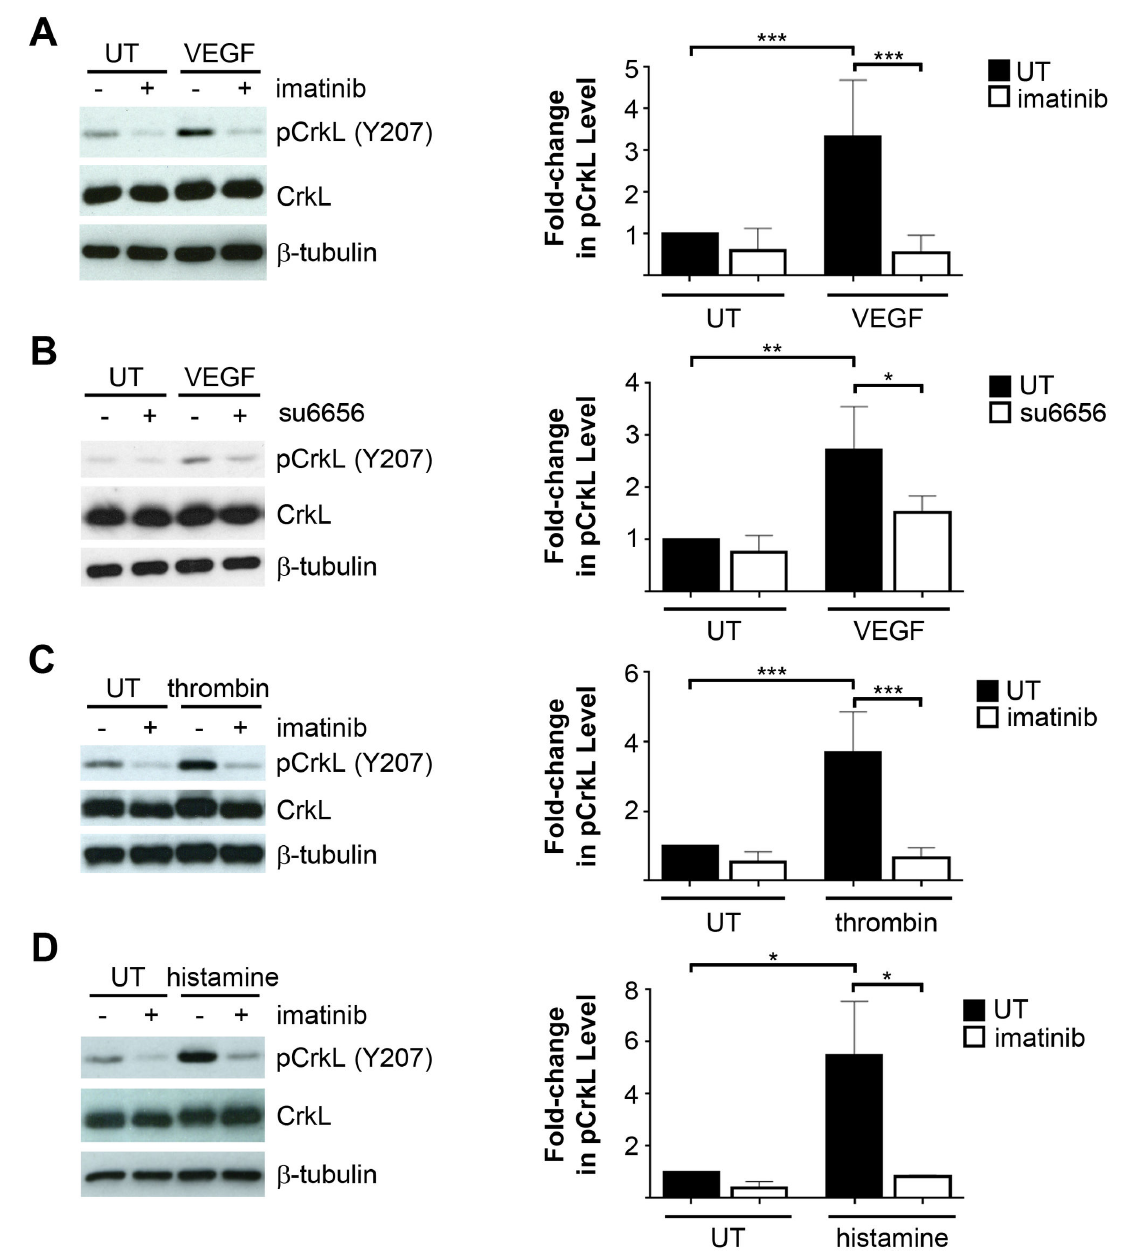
Figure 1. Abl kinases are activated following treatment with endothelial permeability-inducing factors. ( A ) Assessment of Abl kinase activation, as determined by phospho-CrkL tyrosine (Y) 207 levels, following stimulation of serum-starved HMVECs with 100ng/mL VEGF for 5 minutes, with or without imatinib pre-treatment (10μM). pCrkL (Y207) levels (normalized to total CrkL) are quantified in the right panel, relative to levels in untreated (UT) cells. Data are presented as means +/- SD (n=7). ( B ) Evaluation of pCrkL (Y207) levels in HMVECs treated with VEGF, with or without su6656 pre-treatment (1μM). pCrkL levels (normalized to total CrkL) are quantified in the right panel, relative to levels in untreated (UT) cells. Data are presented as means +/- SD (n=2). ( C ) Evaluation of Abl kinase activation (pCrkL Y207) following treatment of HMVECs with thrombin (1U/mL, 5 minutes), with or without imatinib pre-treatment. pCrkL levels (normalized to total CrkL) are quantified in the right panel, relative to levels in untreated (UT) cells. Data are presented as means +/- SD (n=5). ( D ) Assessment of Abl kinase activation (pCrkL Y207) following stimulation of HMVECs with histamine (100μM, 5 minutes), with or without imatinib pre-treatment. pCrkL levels (normalized to total CrkL) are quantified in the right panel, relative to levels in untreated (UT) cells. Data are presented as means +/- SD (n=3). *P<0.05; **P<0.01; ***P<0.001. doi: 10.1371/journal.pone.0085231.g001 PLOS ONE |